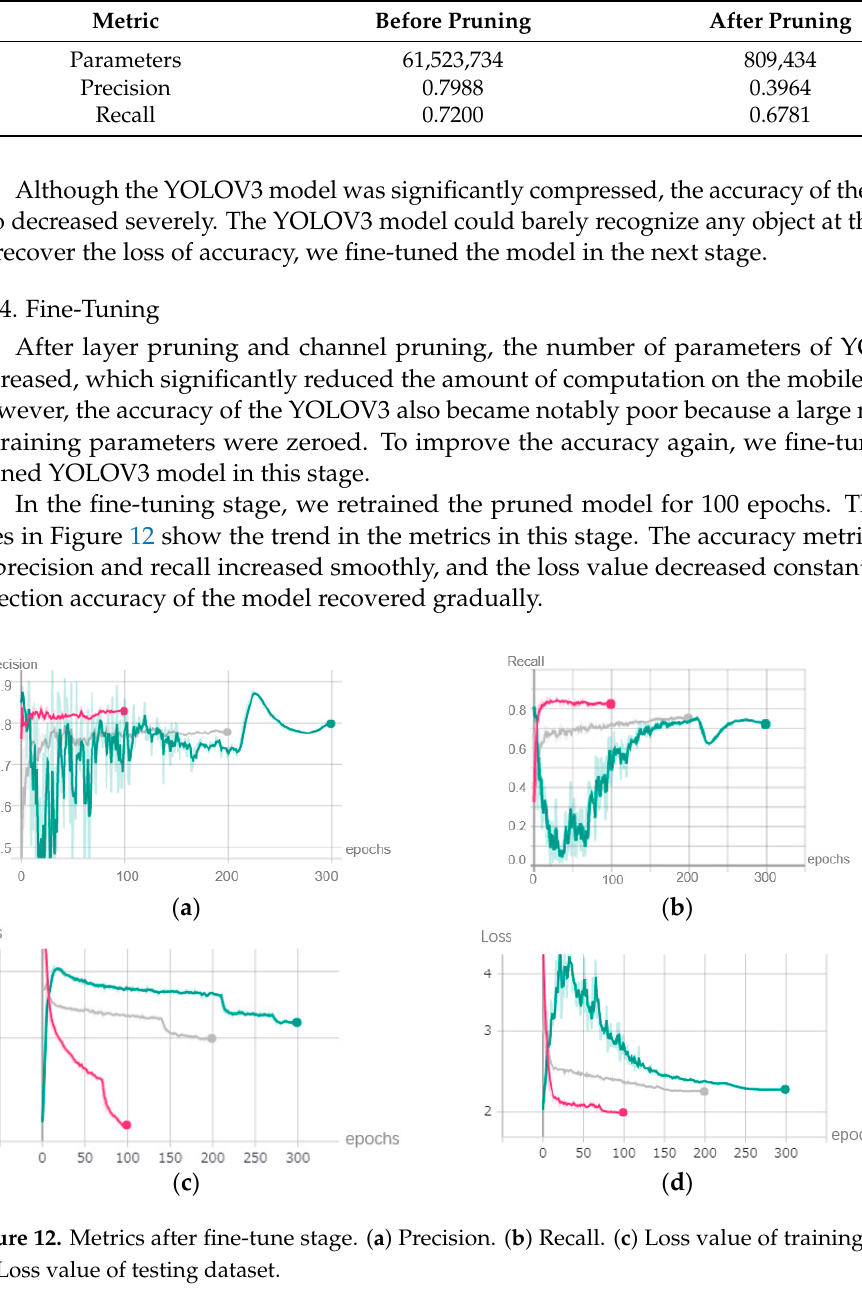
Table 2. Metrics before and after sparsity training.